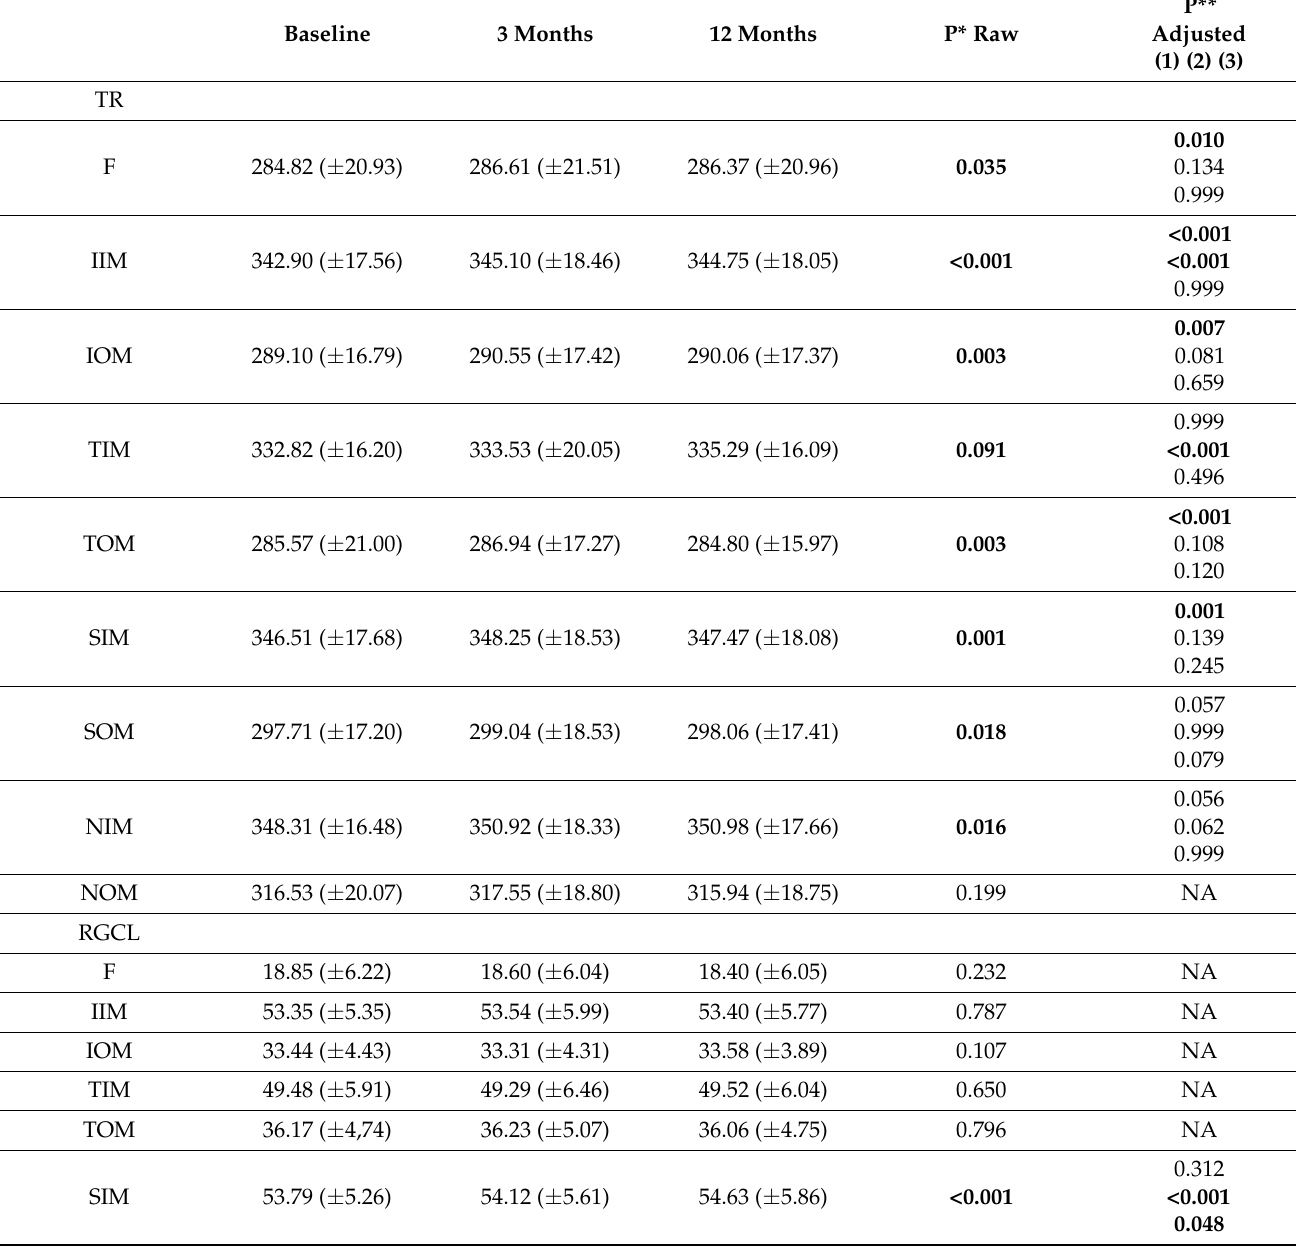
Table 4. Thickness measurements made at the macular level at baseline and at 3 and 12 months of follow up in patients with obstructive sleep apnea undergoing continuous positive airway pressure treatment.